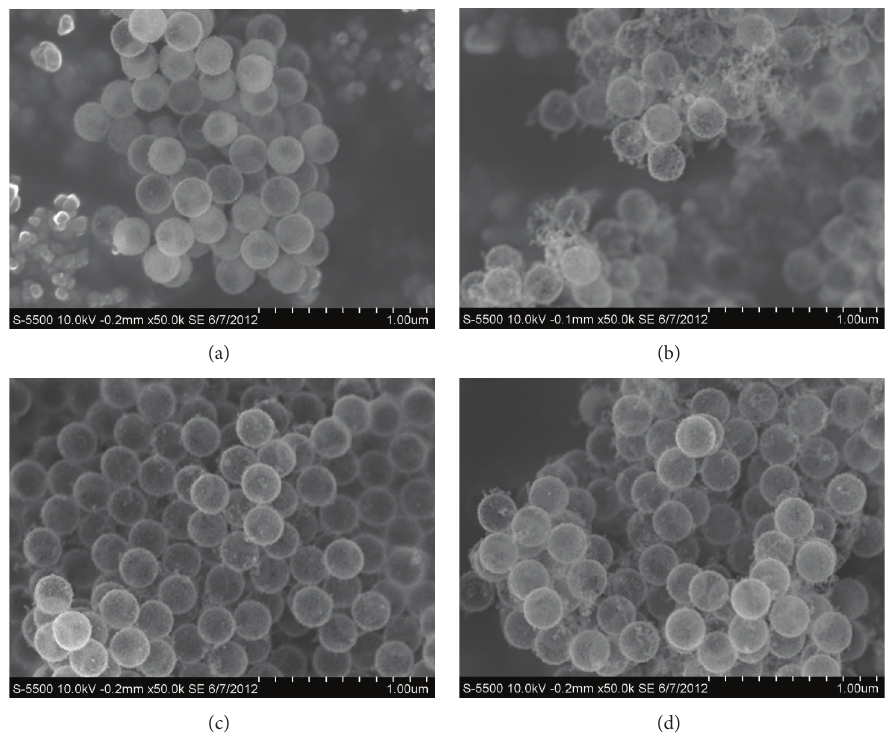
Figure 5: SEM images of (a) for Sample A, (b) for Sample B, (c) for Sample C, and (d) for Sample D after removal of PS templates.